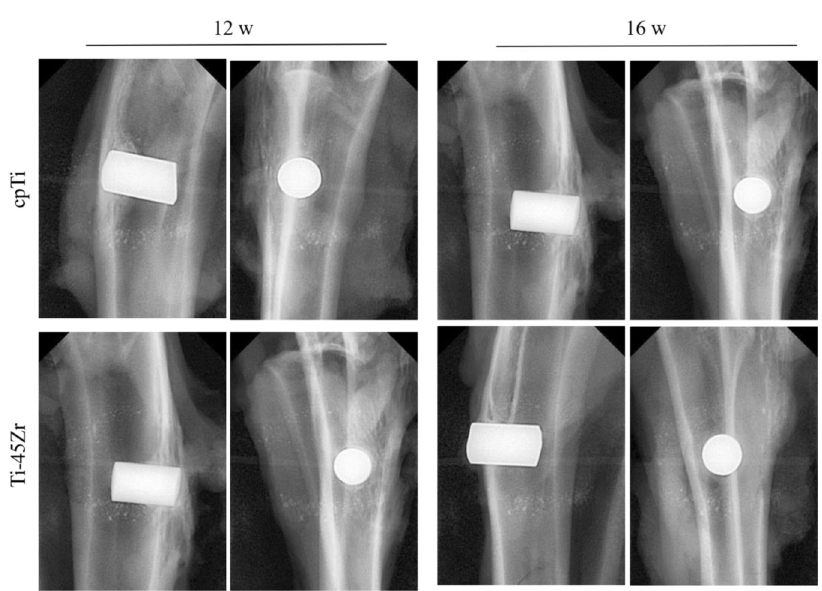
Fig. 12 Anteroposterior and lateral radiographs of rabbit femoral specimens with implant